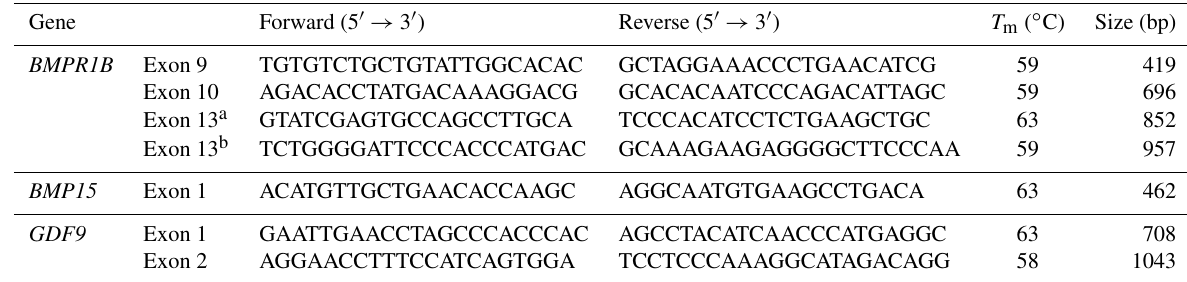
Table 1. Genes affecting multiple births, size, and T m degrees. Gene Forward (5 (cid:48) → 3 (cid:48)